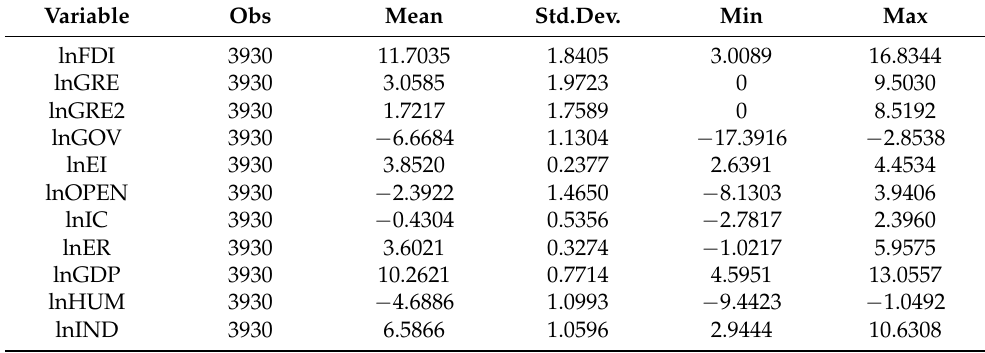
Table 1. Summary